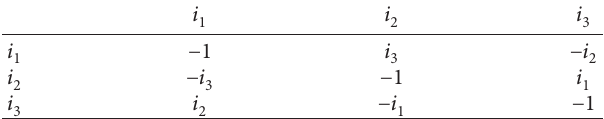
Table 1: Imaginary units